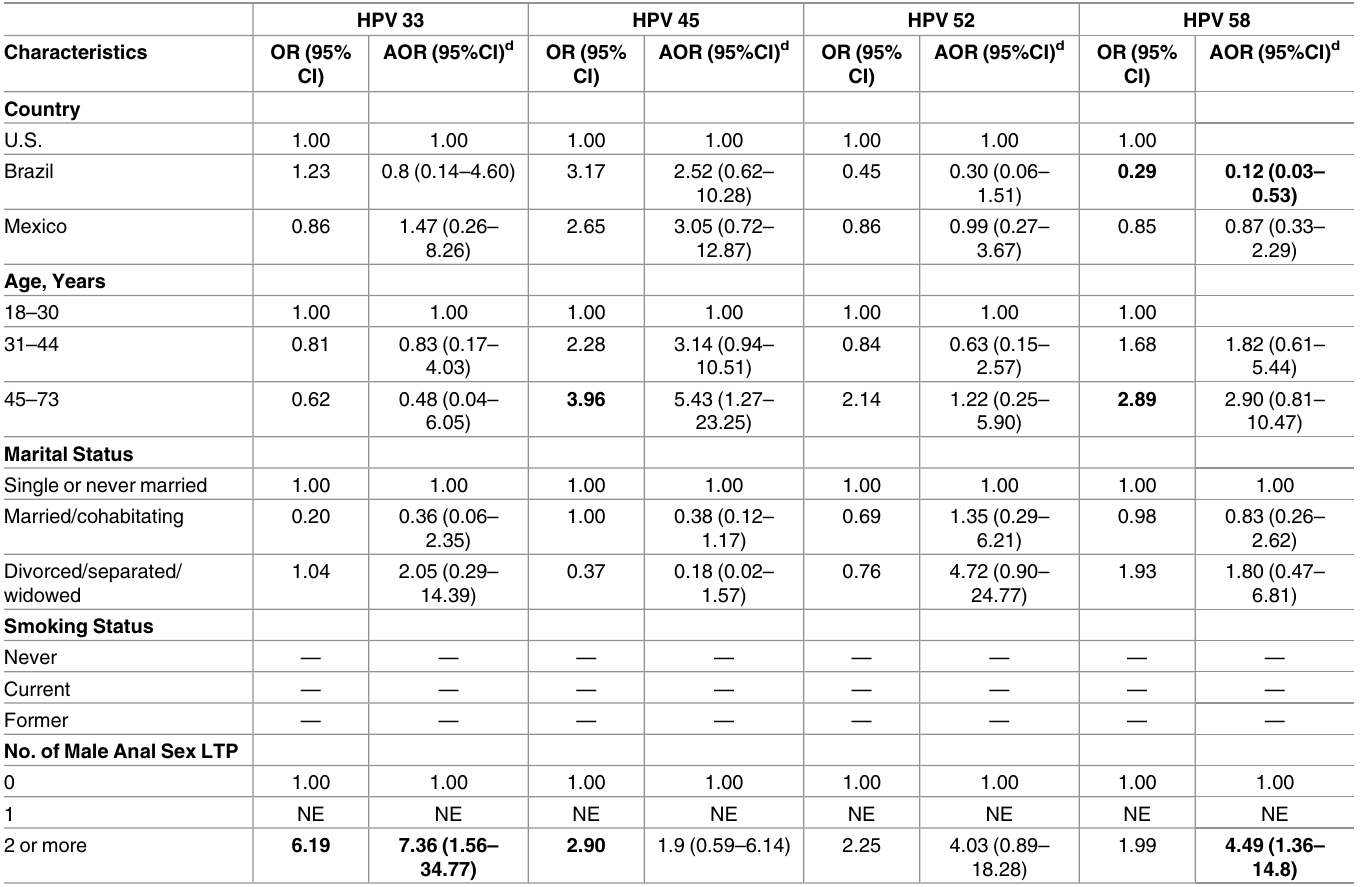
Table 5. Factors independently associated with seropositivity of nine vaccine type HPV in men from Brazil, Mexico and the United